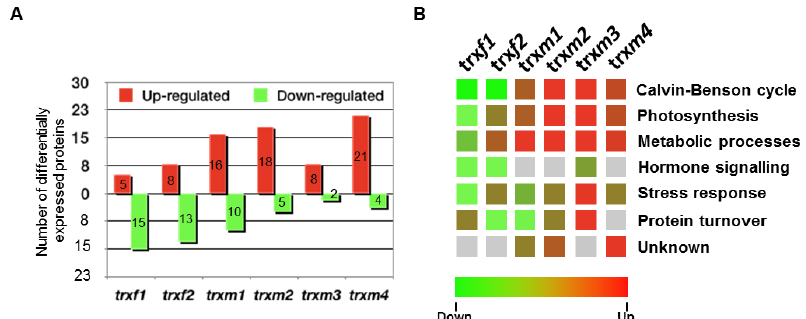
Figure 3. Processes down- or up-regulated in the trx mutants, number of coincident spots identified by proteomic analyses. ( A ) number of proteins down- or up-regulated in trxf or trxm mutants; ( B ) biological processes affected in each mutant line. Table 1. Differentially expressed proteins identified by MS in the trxf1 and trxf2 mutants, organized inthe functional category, the gene code and the subcellular localization and whether the protein has been reported as a Thioredoxins ( TRX) target. The color code indicates fold change in protein abundance.